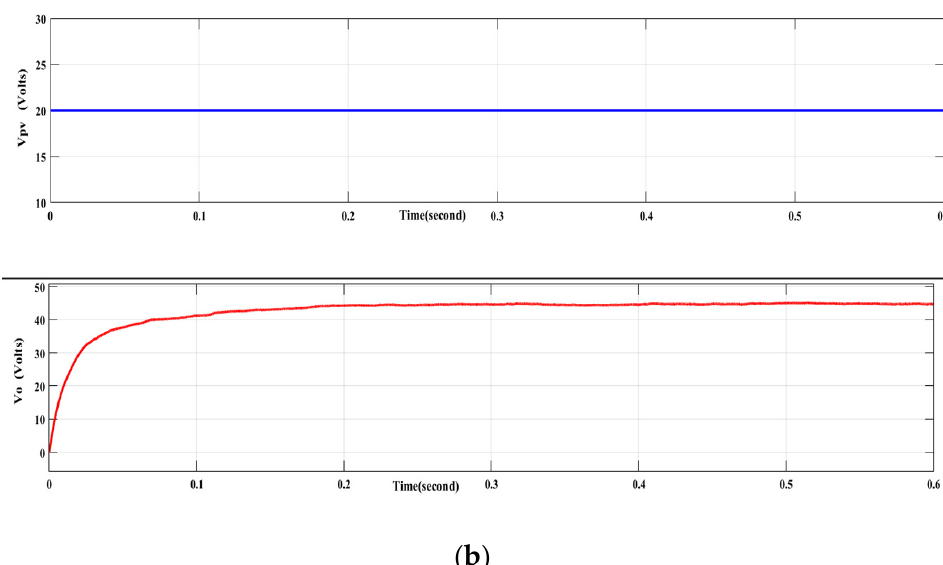
Figure 6. Simulation result of the proposed IIABB converter for solar PV module input voltage V pv of 20 V and corresponding output voltage V o = 48 V and number of connected inductors N = 1 with duty cycle 0.7 ( a ) gate pulse waveform where S A and S B are in operating condition and S C and S D are not operating, and ( b ) the V pv and output voltage V o .